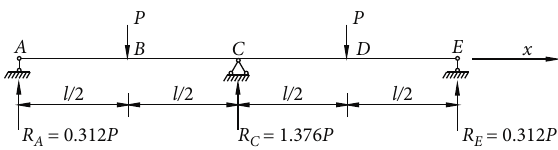
Figure 3: The schematic representation of two equal span con- tinuous composite box girders with CSWSB under concentrated load